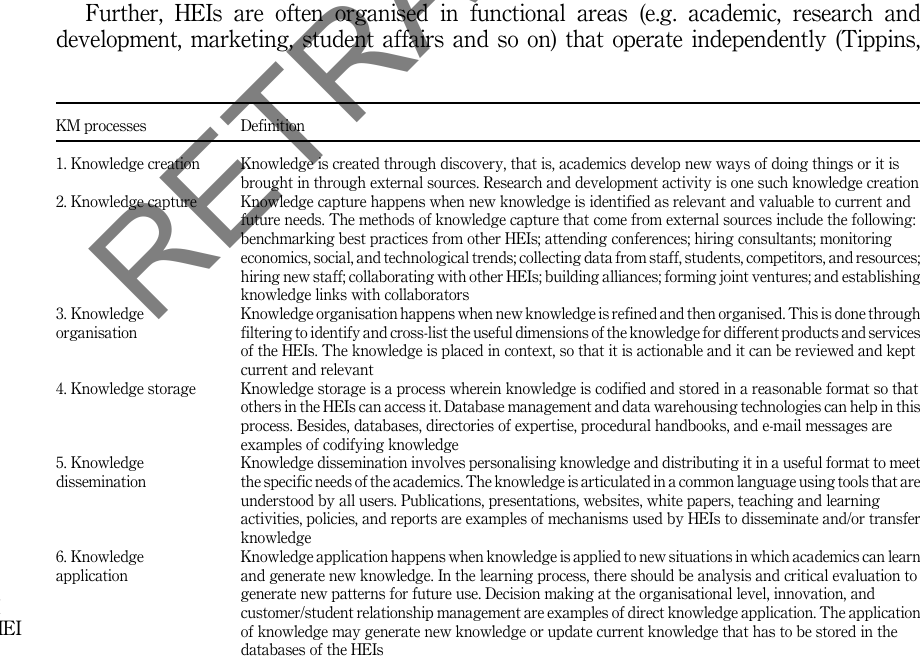
Table I. Definitions of KM processes in the HEI